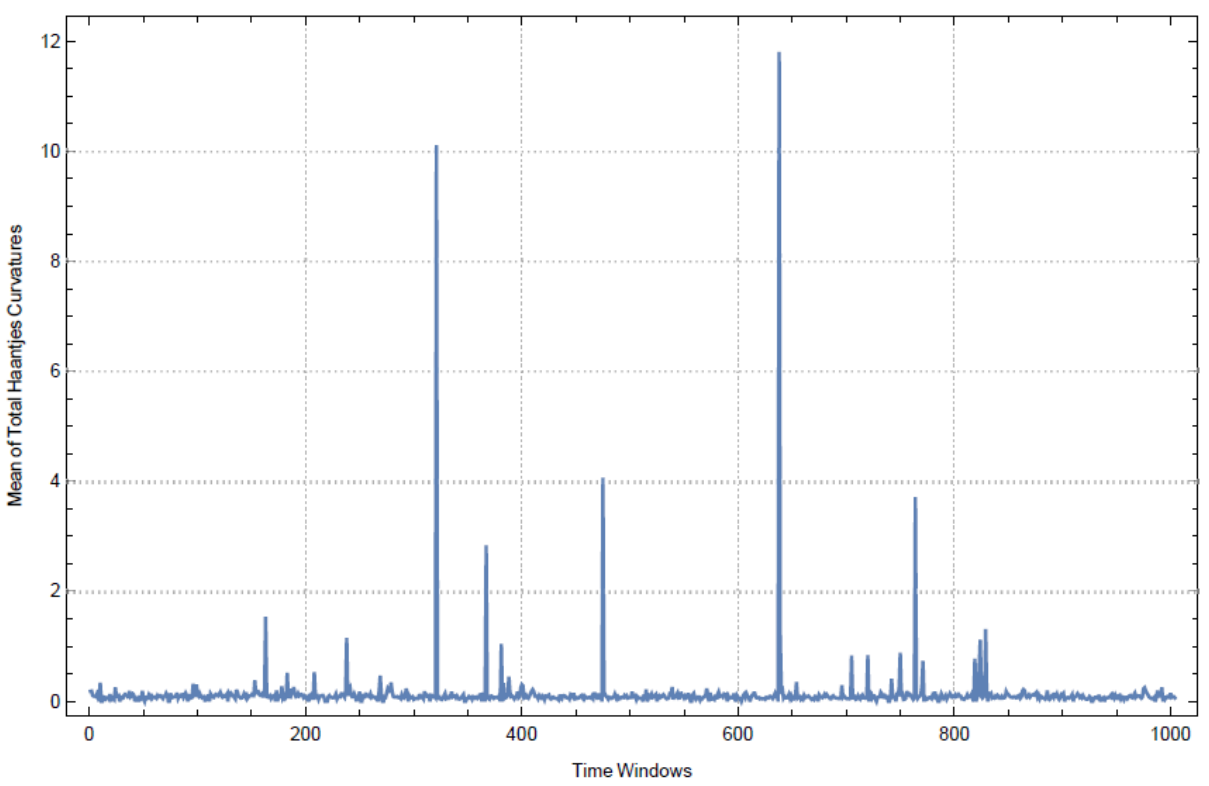
Figure 10. Means of the total Haantjes curvatures of VDG of 𝐺 (cid:3021)(cid:3037) for Nasdaq-100 using TMFG filtra- tion.